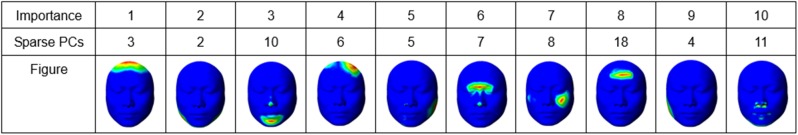
The proportion of each component in the most ten similar craniofacial comparison.